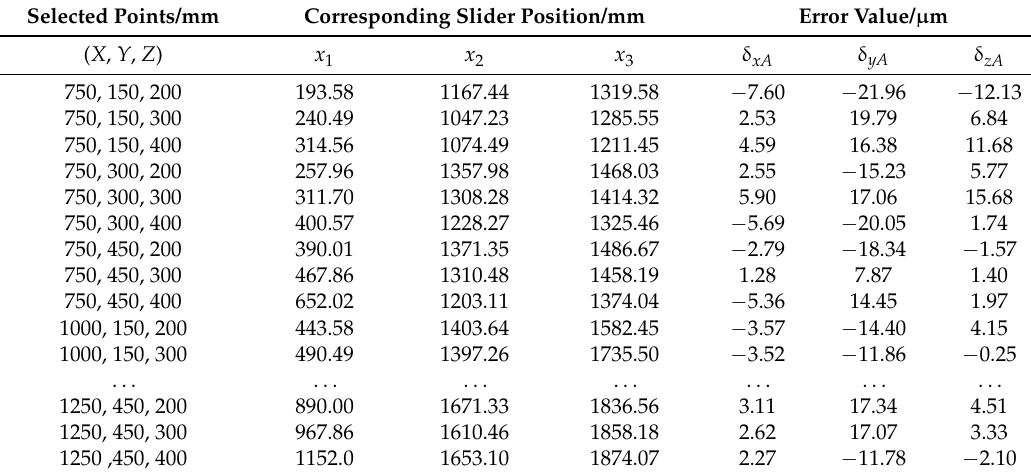
Table 2. Error contributed by Abbe error of three sliders.